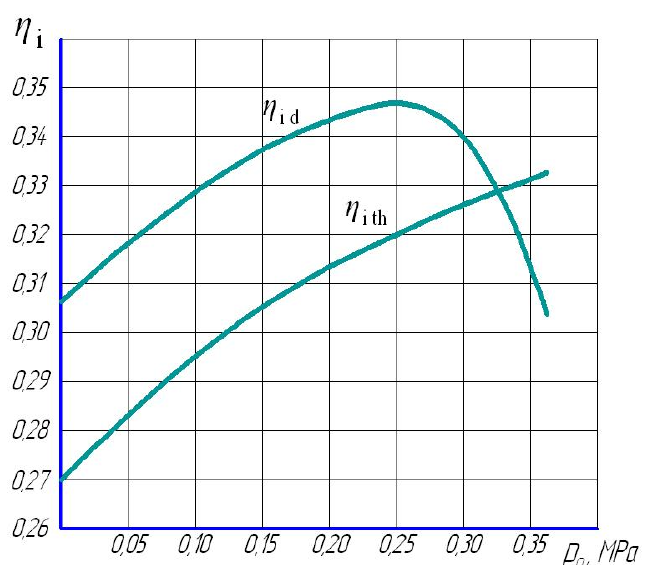
Figure 1. The dependency of the indicated efficiency on the average effective pressure when six cylinders are throttled and when three cylinders are switched off (Opel C30 LE engine). Indices: th, index to indicate throttling; d, index to indicate deactivation; η ith , indicated efficiency of throttling; η id , indicated efficiency when three cylinders are switched off (deactivated).